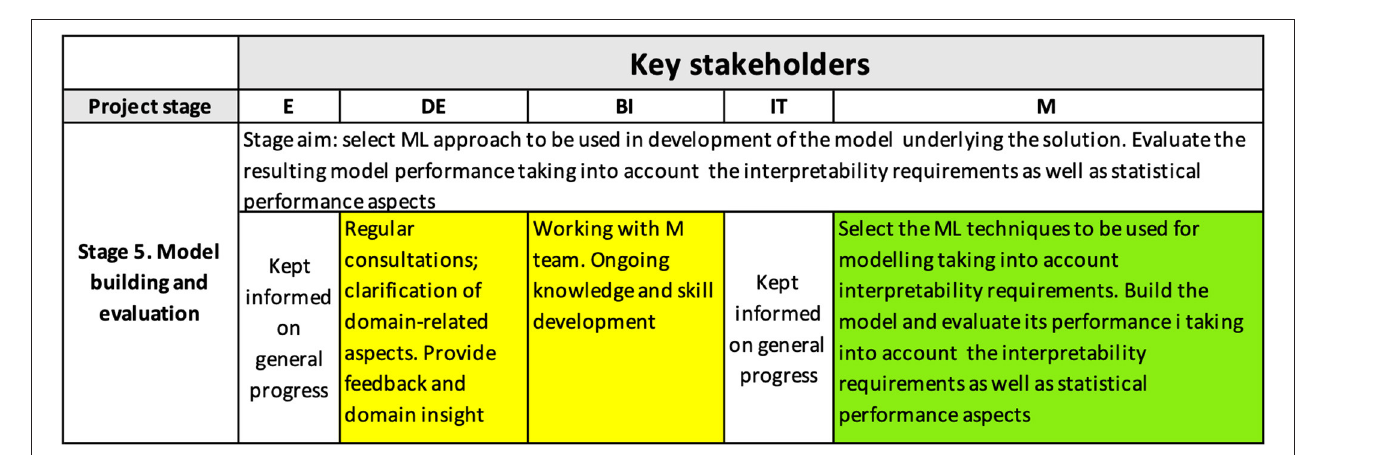
FIGURE 7 | Interpretability matrix content for Stage